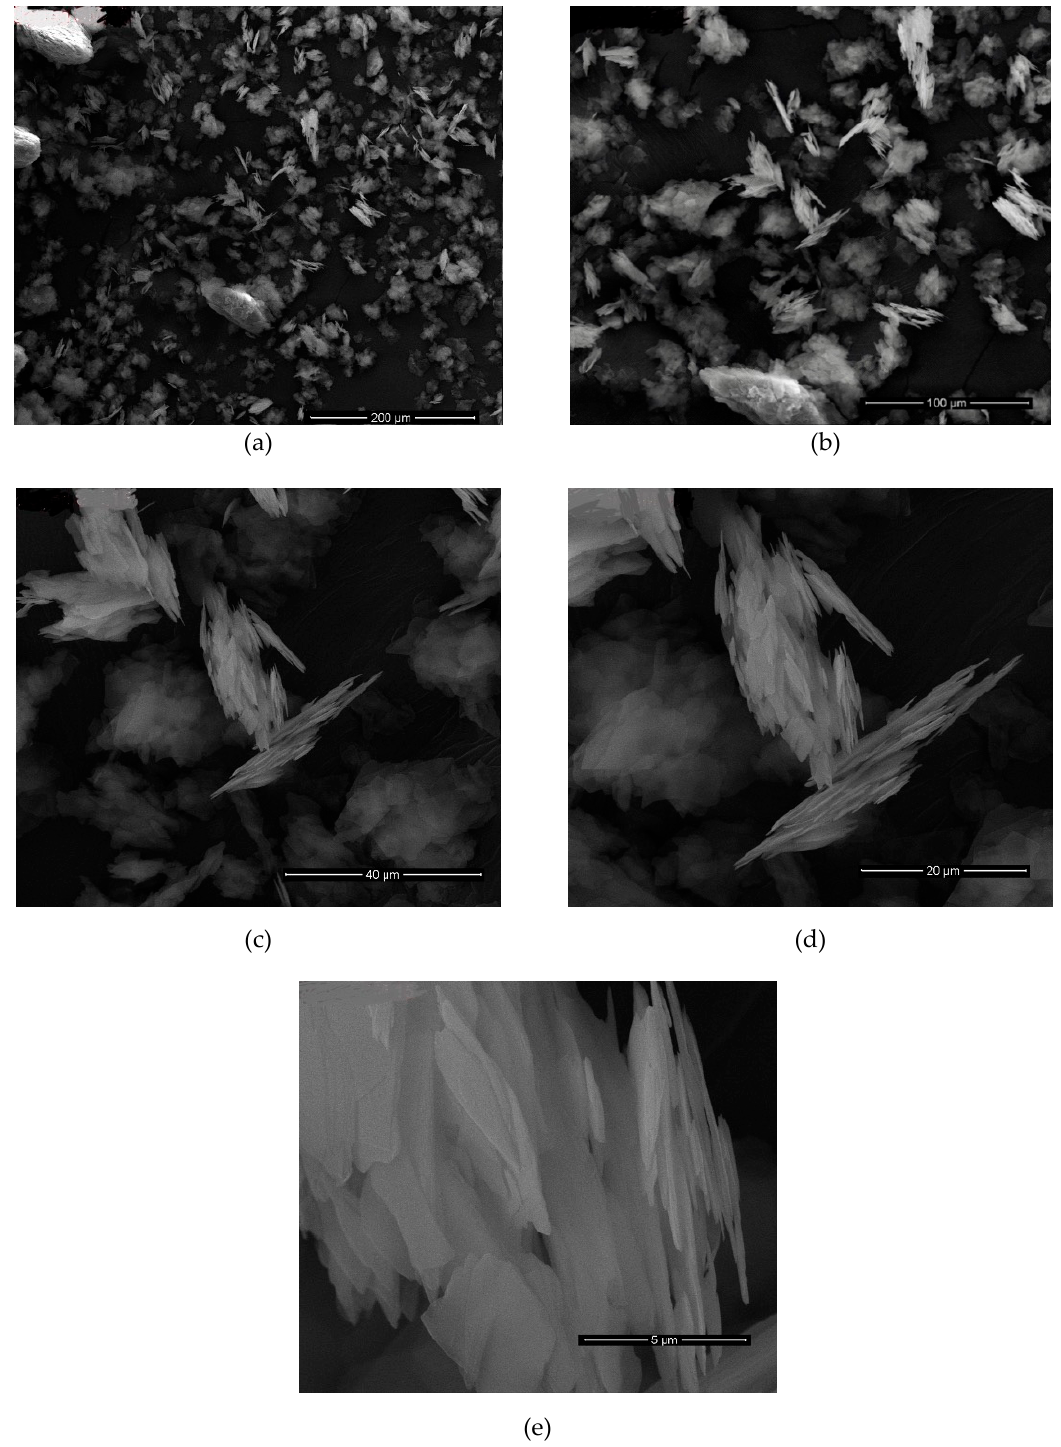
Figure 6. SEM images of the M x2c2 sample with a sonication time of 9 h (all images same as with higher magnification) ( a ) 500×; ( b ) 1000×; ( c ) 3000×; ( d ) 5000×; ( e ) 20,000×.